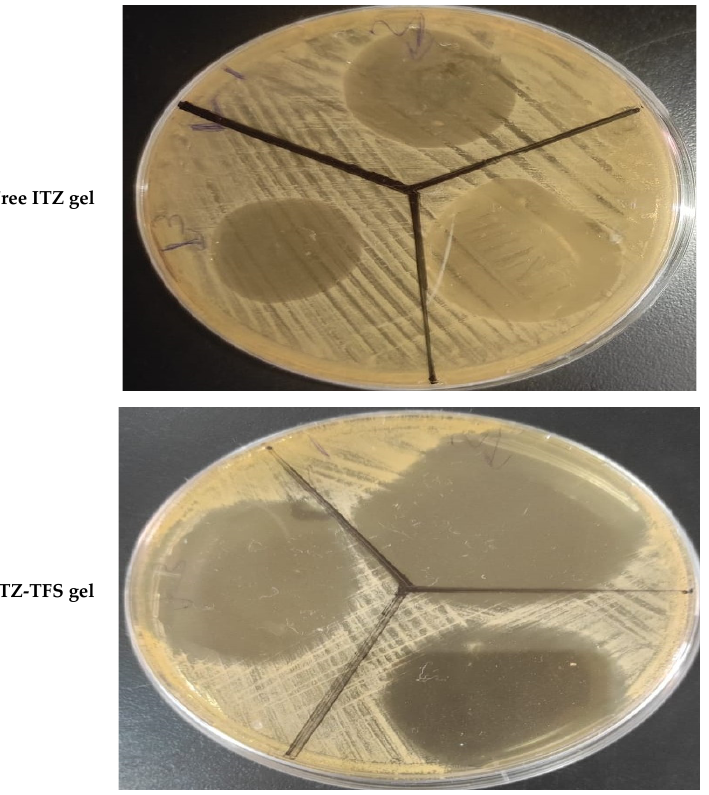
Figure 9. In vitro antifungal activity test showing the zone of inhibition of free ITZ gel and ITZ-TFS gel .